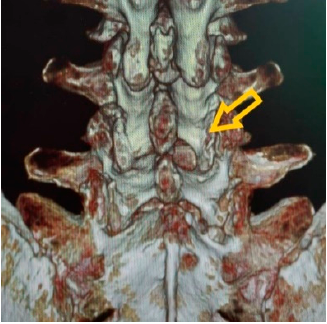
Figure 2. Postoperative CT scan after interlaminar percutaneous endoscopic decompression (PED). Yellow arrow indicates area of laminotomy.